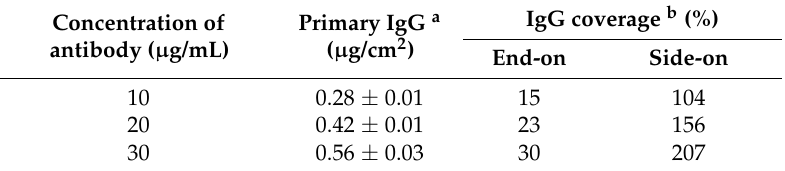
Table 2. Amount of the primary antibody immobilization on the (PDDA/PAA) 3